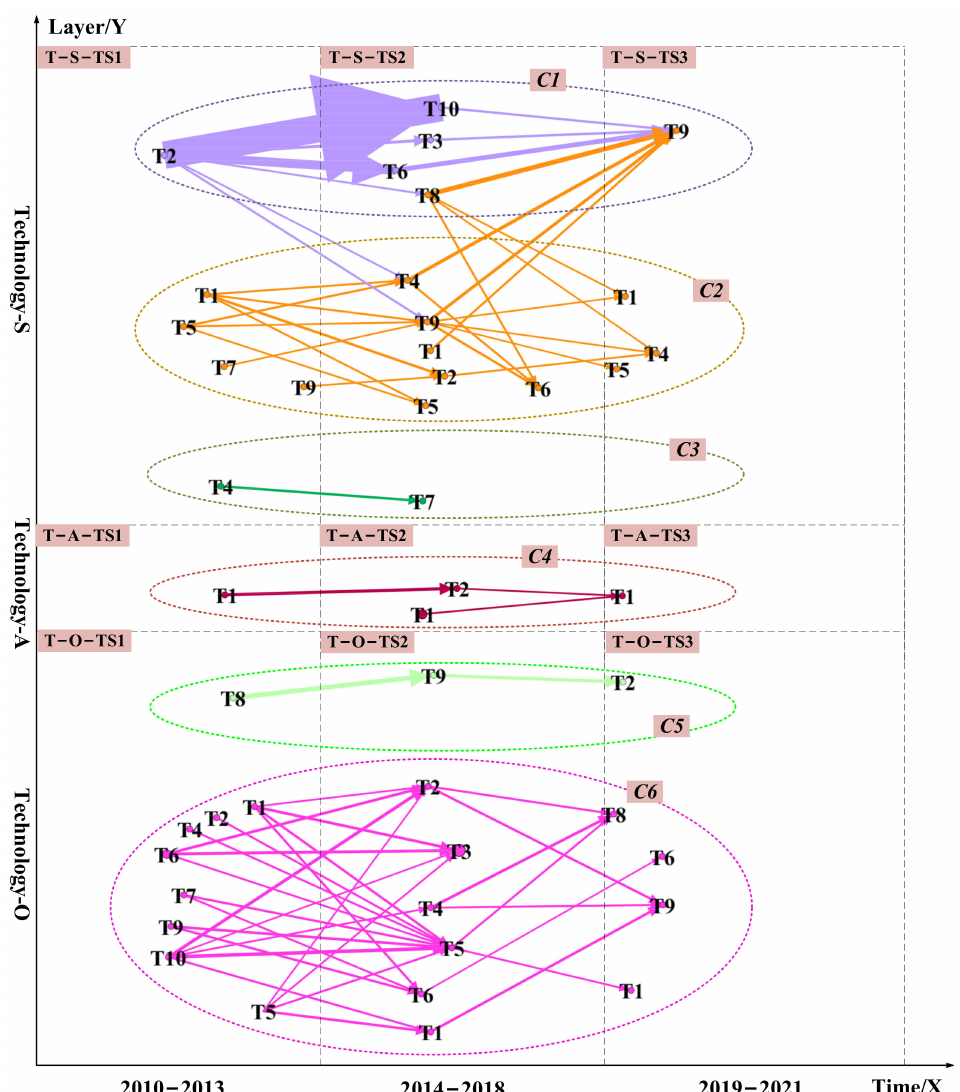
Figure 3. The data-driven TRM for the technology layer. The technical layer was divided into six communities represented by C 1 , C 2 , C 3 , C 4 , C 5 , and C 6 . Dashed cycles with different colors highlight diverse communities. The edges’ width and arrows’ width represent the probability of a potential link between unconnected nodes. The wider the edges and arrows, the higher the likelihood of a potential link. Arrows and edges with different colors represent different community